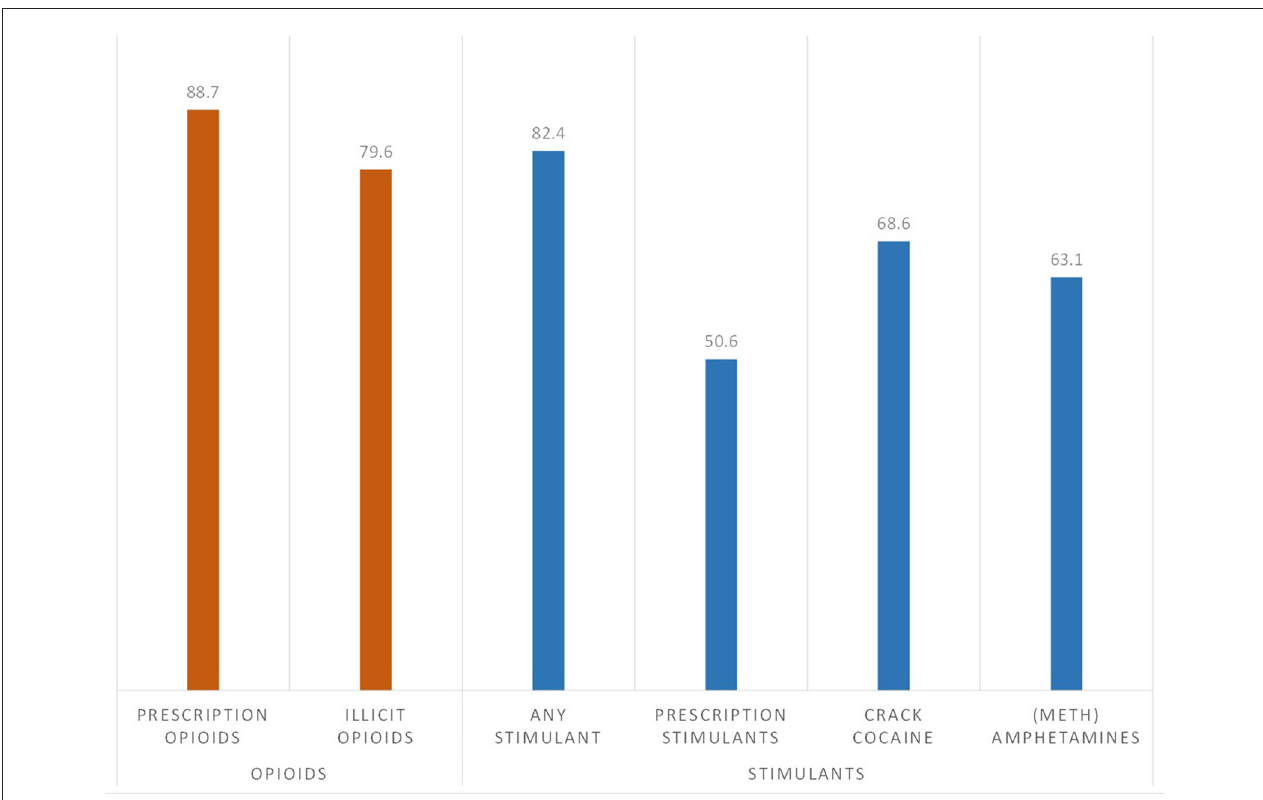
FIGURE 1 | Prevalence of lifetime exposure to opioid and stimulants among individuals with opioid use disorder ( n = 7,109), adjusted for age of initial drug exposure and time since year of initial drug exposure.